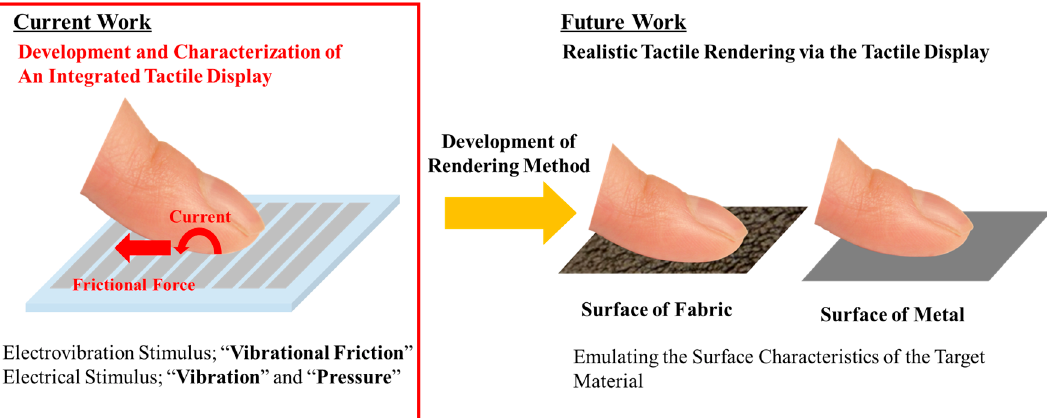
Figure 1. Concept of the proposed tactile display. The tactile display can provide both electrovibration stimulus and electrical stimulus with an array of electrodes. In this study, we revealed that the multiple stimuli were able to be perceived by the subjects.